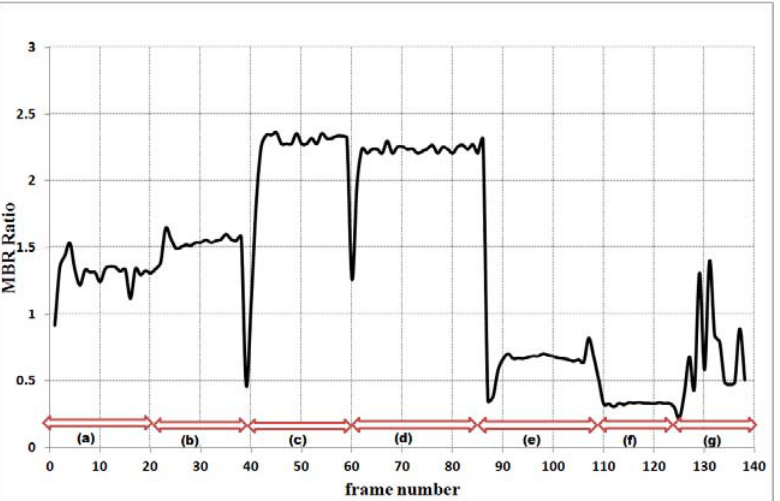
Figure 3. Variations in the MBR ratio: ( a ) Backward fall; ( b ) Forward fall; ( c ) Falling to the left; ( d ) Falling to the right; ( e ) Crouching down and standing up; ( f ) Standing; ( g )